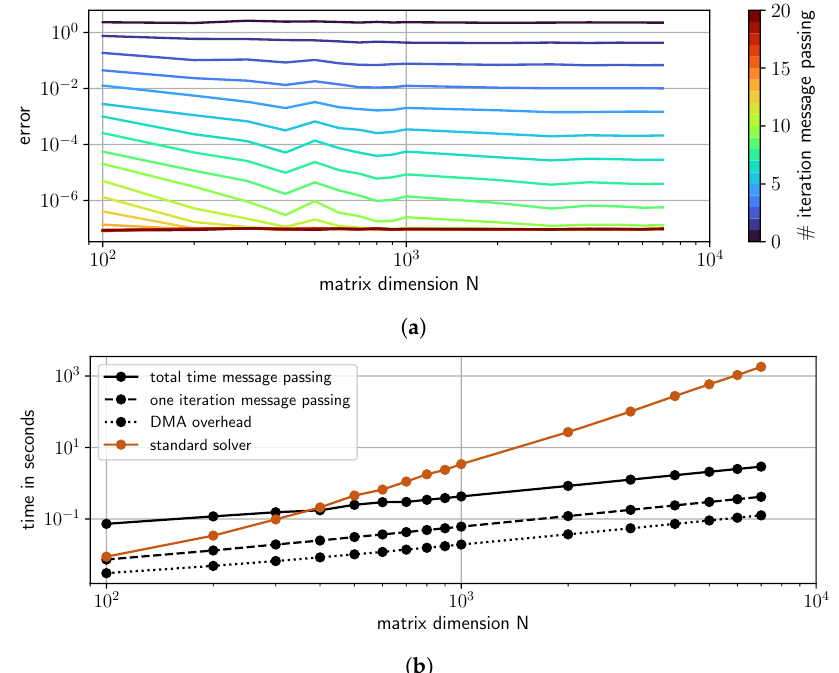
Figure 11. The plots show the same results as Figure 10. However, this time for the PYNQ-Z1 board. Due to less memory, only LESs with dimension N less than 8000 are evaluated. The plots in ( a ) illustrate the convergence, where ( b ) shows the required computation